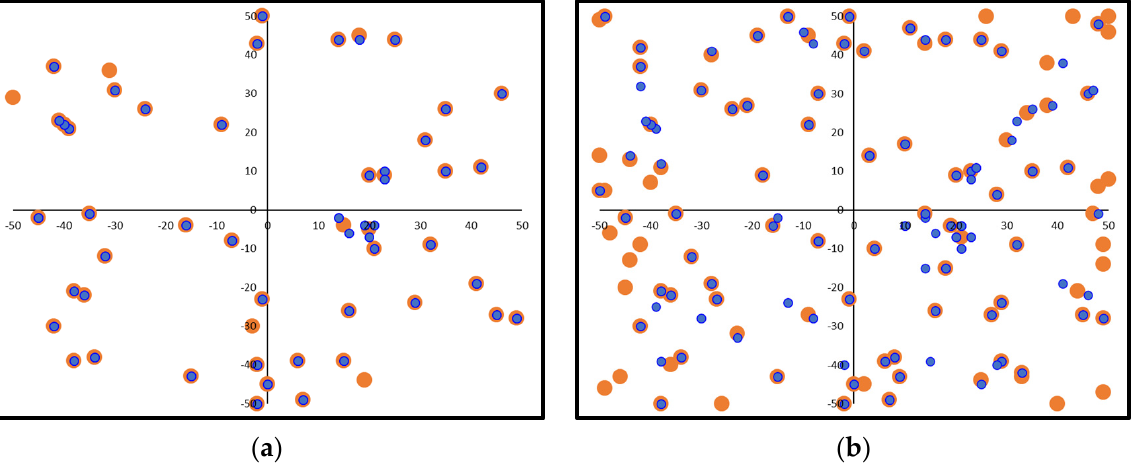
Figure 12. Indicative charging station deployment optimization results for Case Study 7: ( a ) 50 de- mand points; ( b ) 100 demand points (demand points in blue color, charging stations in orange color).